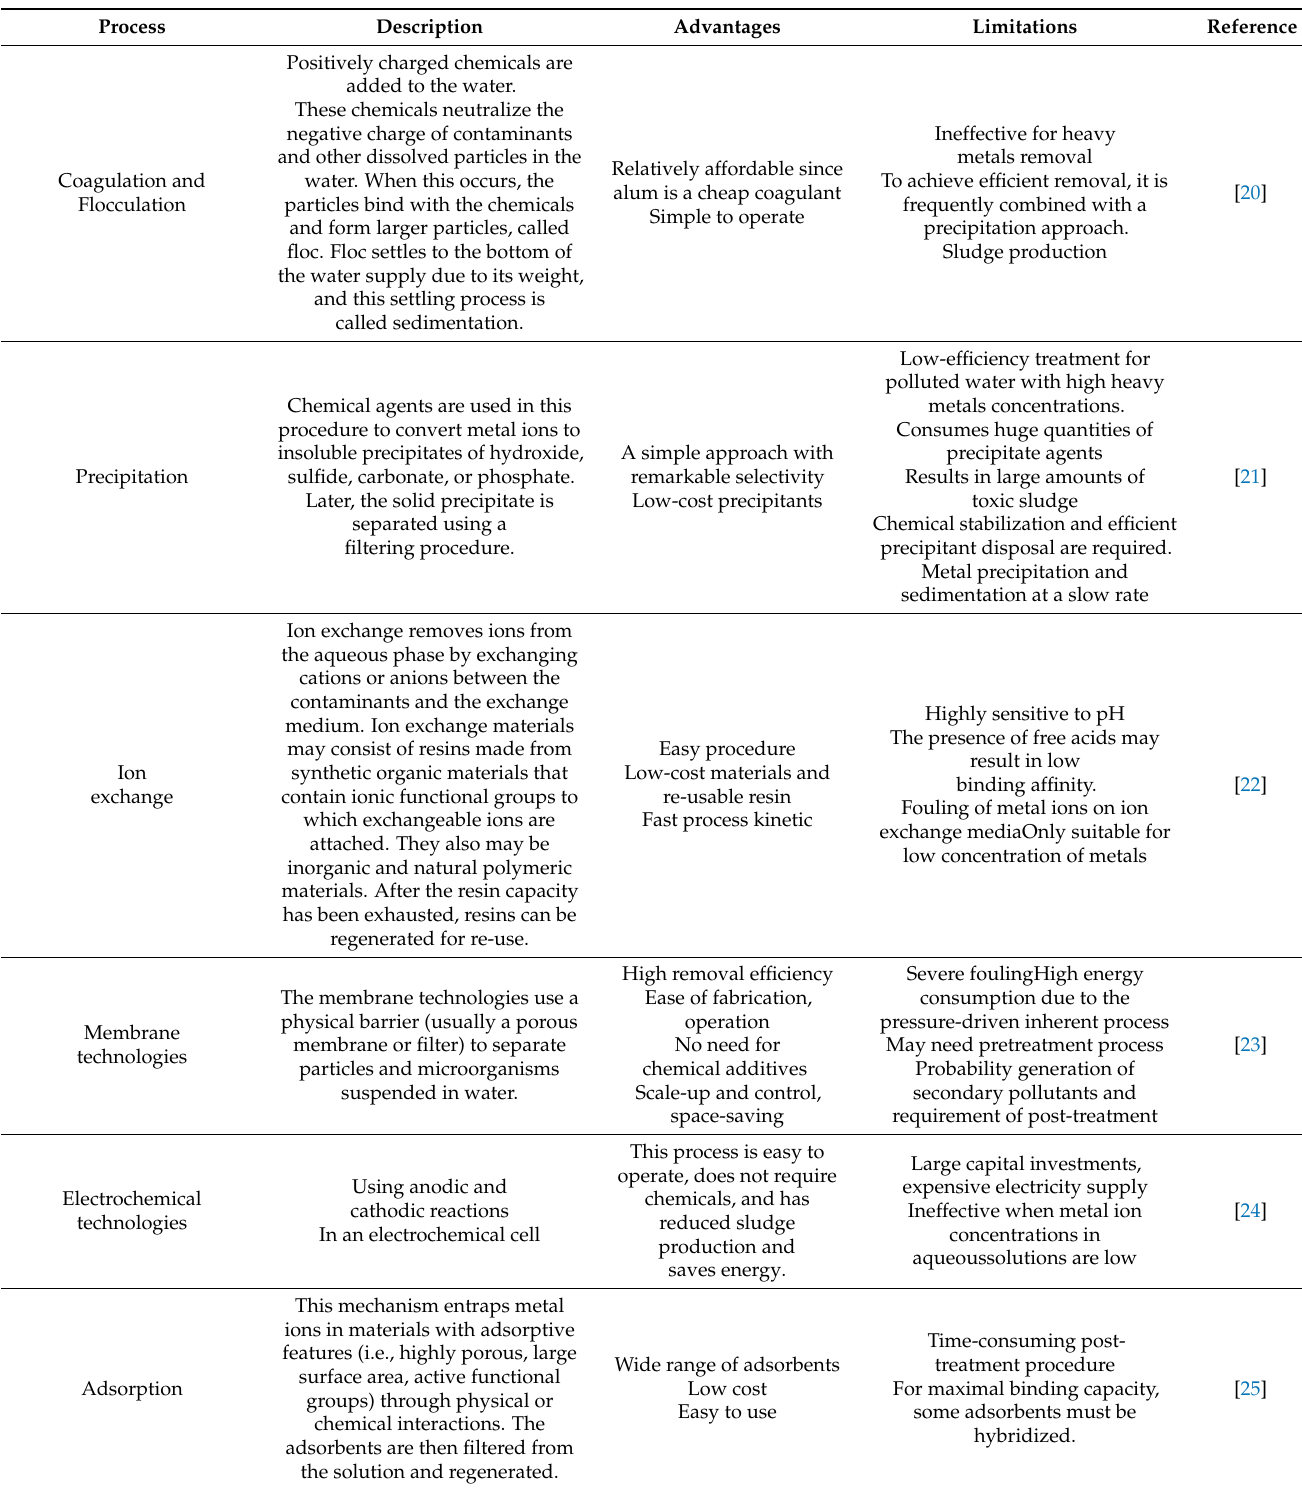
Table 1. Common techniques for remediation water and wastewater and heavy metals